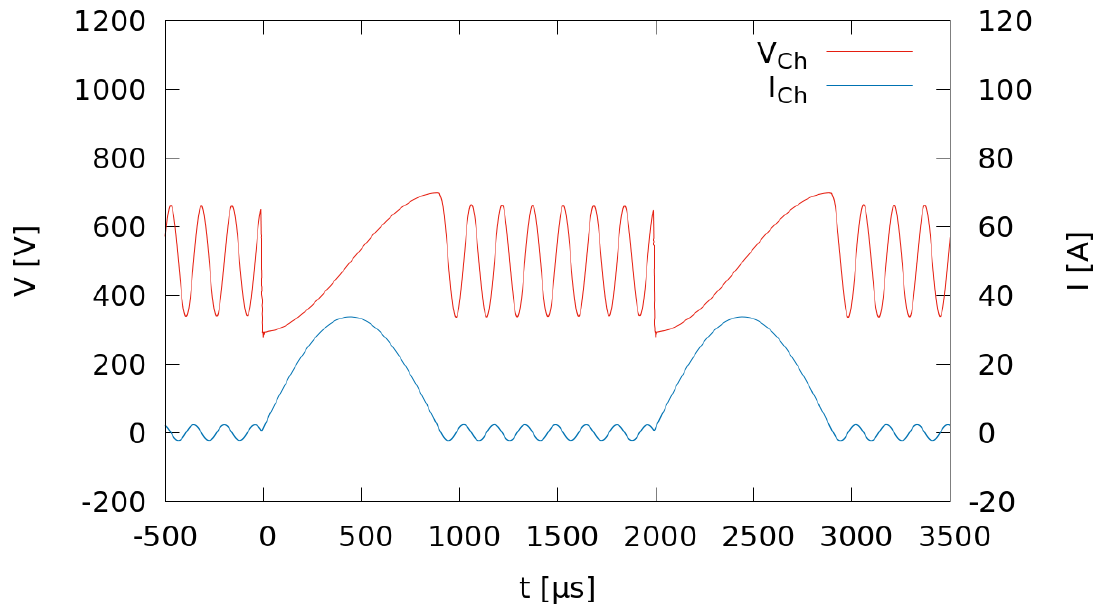
Figure 17. Charging voltage V ch and the charging current I ch at the charging input terminal of the generator, on-time of the solid-state switches: t on = 10 µs.